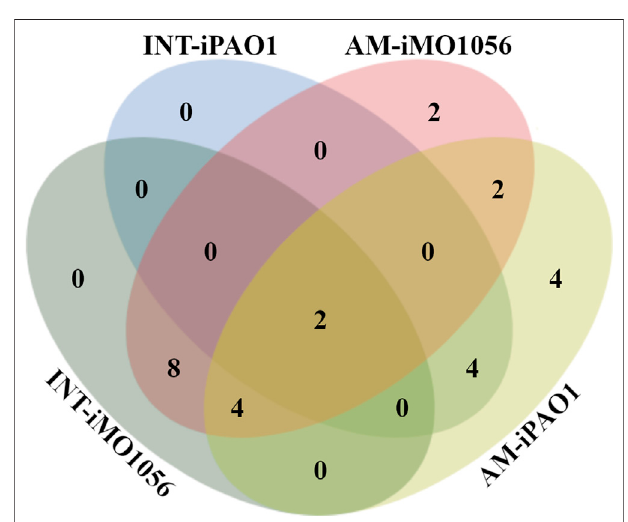
FIGURE 5 | Venn diagram illustrating the number of targets shared by the metabolic models with adjusted carbon source uptake rates (AM) and integrated models